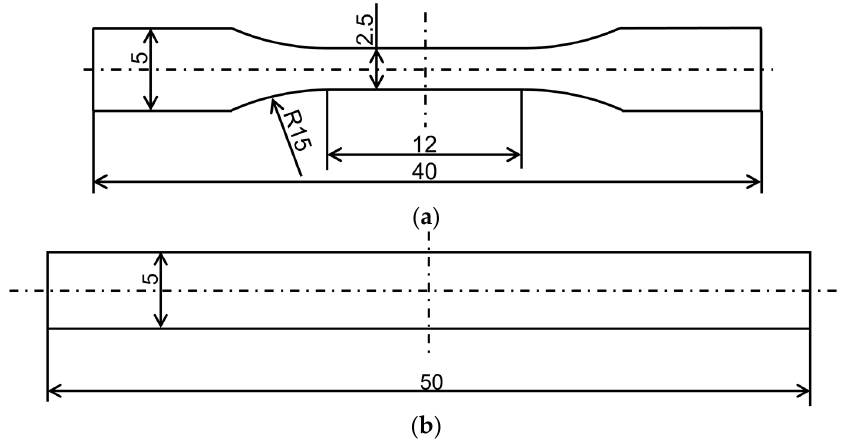
Figure 1. Specimen geometries: ( a ) dumbbell thickness: 1 mm; ( b ) beam thickness: 2 mm.